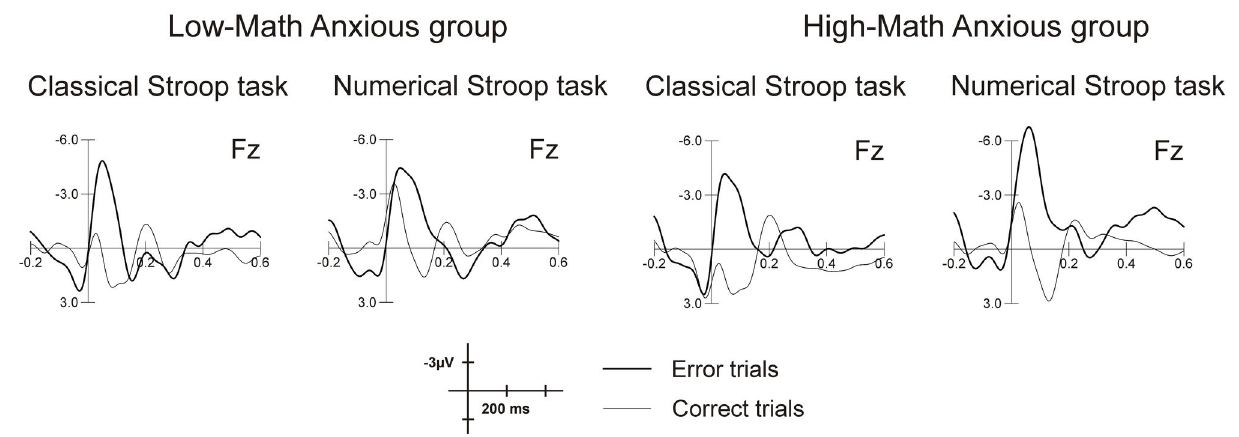
Figure 2. Raw grand average waves for correct and error trials for LMA and HMA groups in the classical and the numerical Stroop tasks at